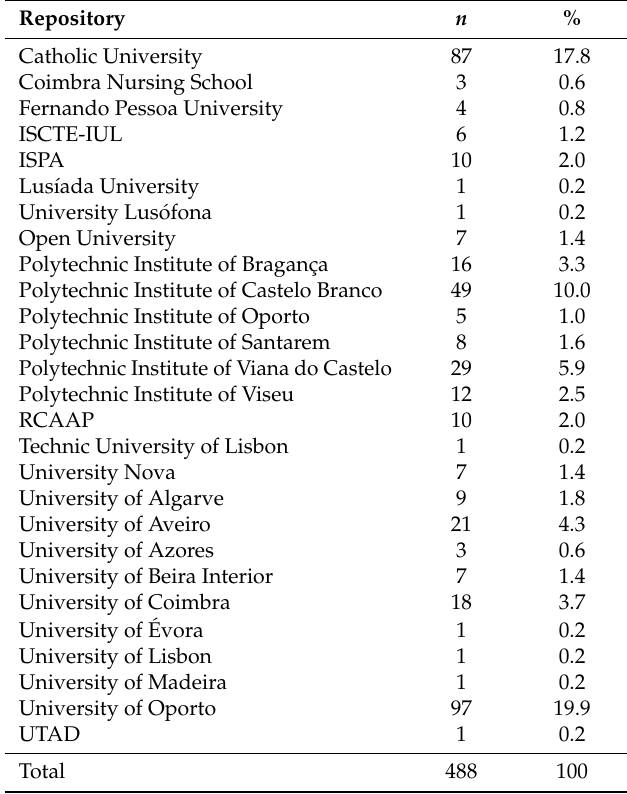
Table 1. Distribution of scientific production by repository ( n and %).